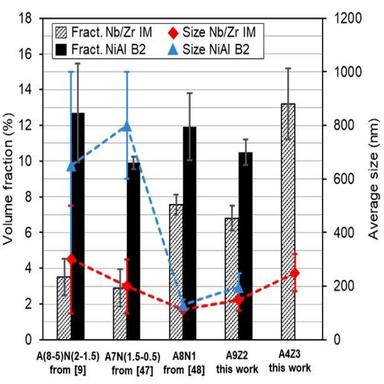
Average volume fraction and size of A9Z2 and A4Z3 compared to Typical AFA Steels with compositional ranges A(8-5)N(2-0.5). A denotes the Al content, N the Nb content and Z the Zr content in at.% respectively. Error bars represent the standard deviation of the calculated average values.